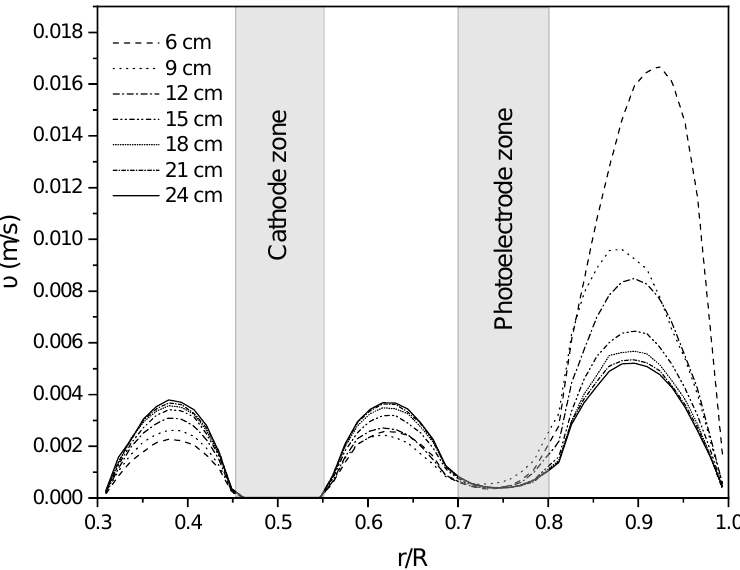
Figure 17. Velocity magnitude profile every 3 cm along photoreactor length (70 cm) using the PM